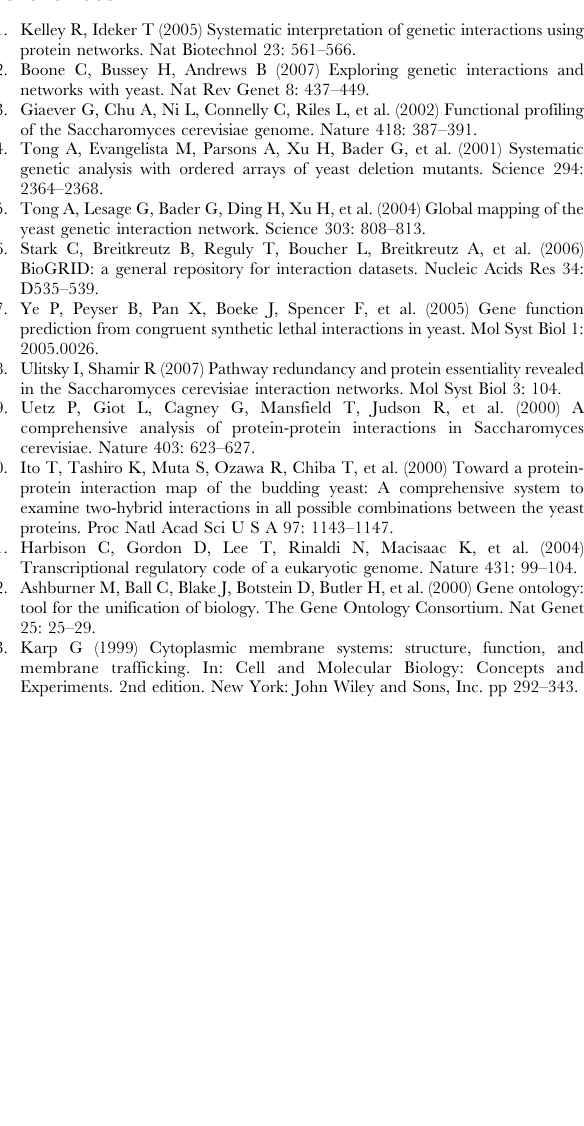
Table S1 Network of compensatory biological